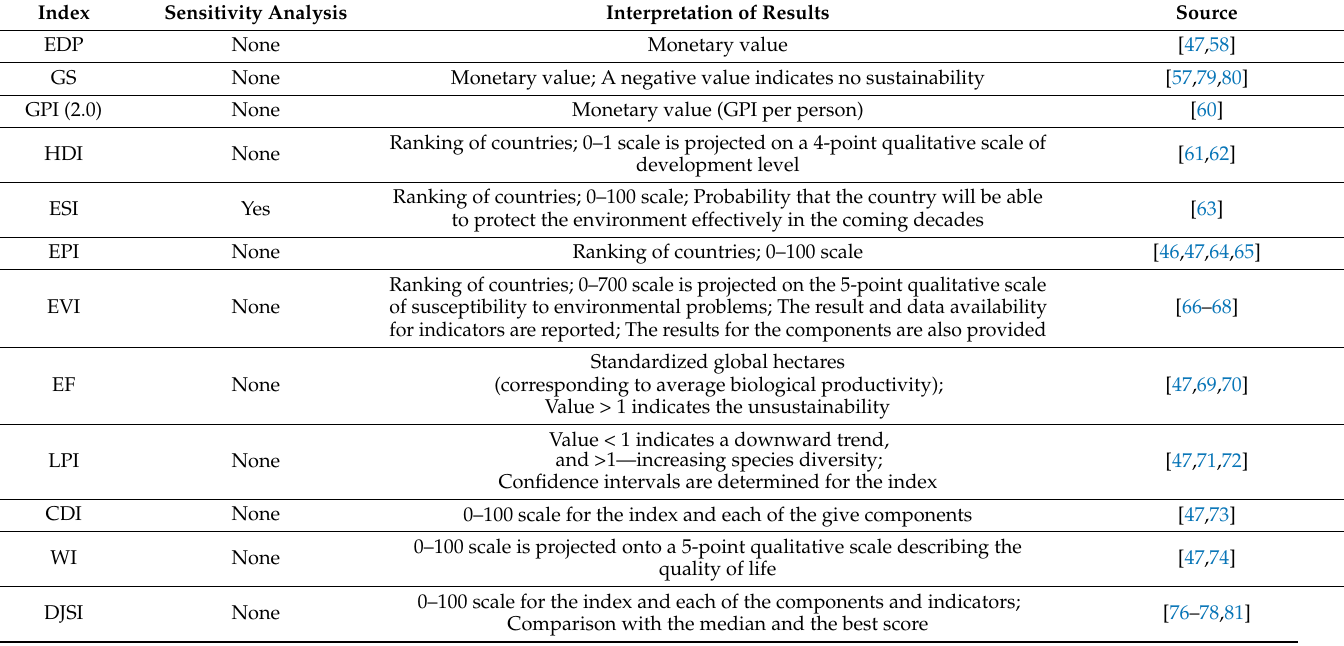
Table 4. Comparison of selected sustainability indices (part